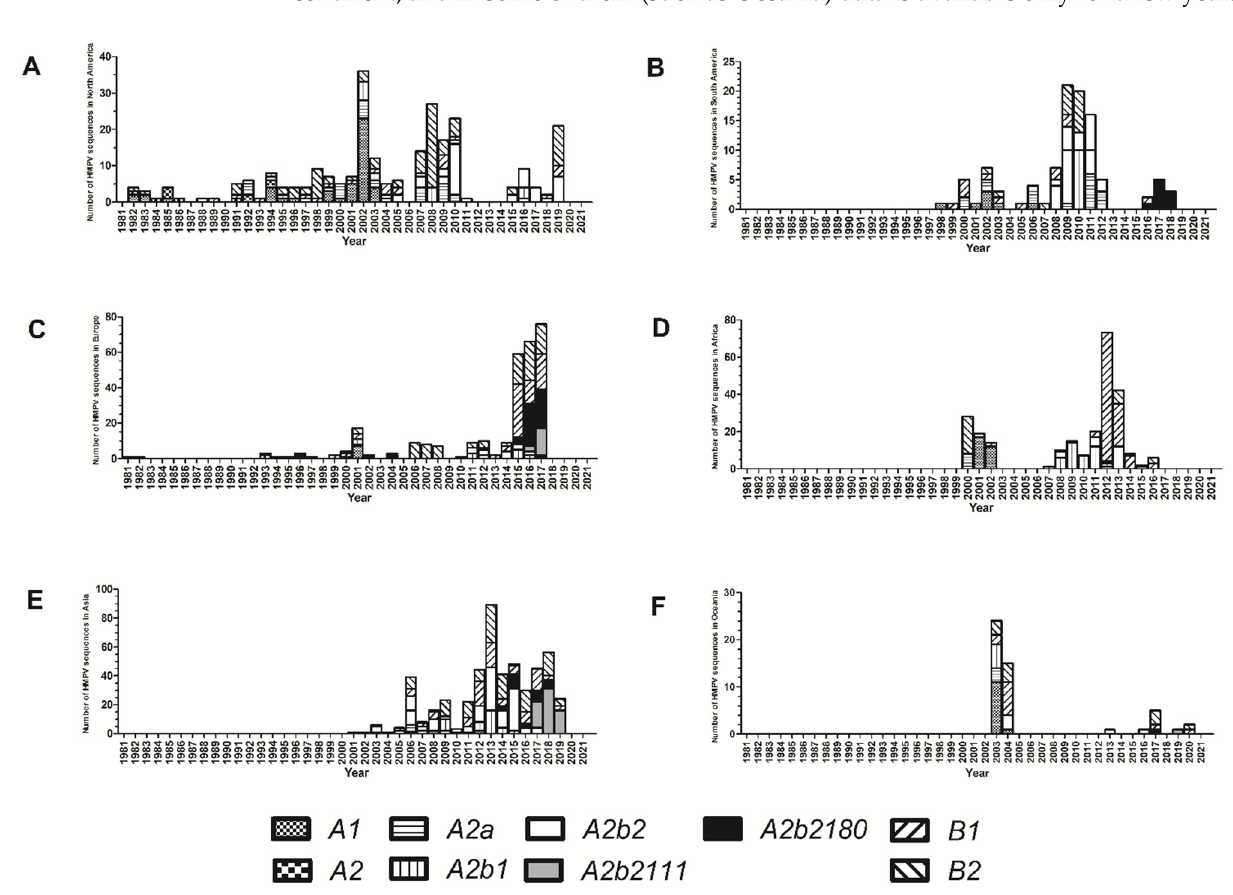
Figure 4. Number of human metapneumovirus (HMPV) sequences assigned to each genotype during each year in North America ( A ), South America ( B ), Europe ( C ), Africa ( D ), Asia ( E ), and Oceania ( F ) based on complete G gene ectodomain analysis for sequences available at GenBank up to December 2021.